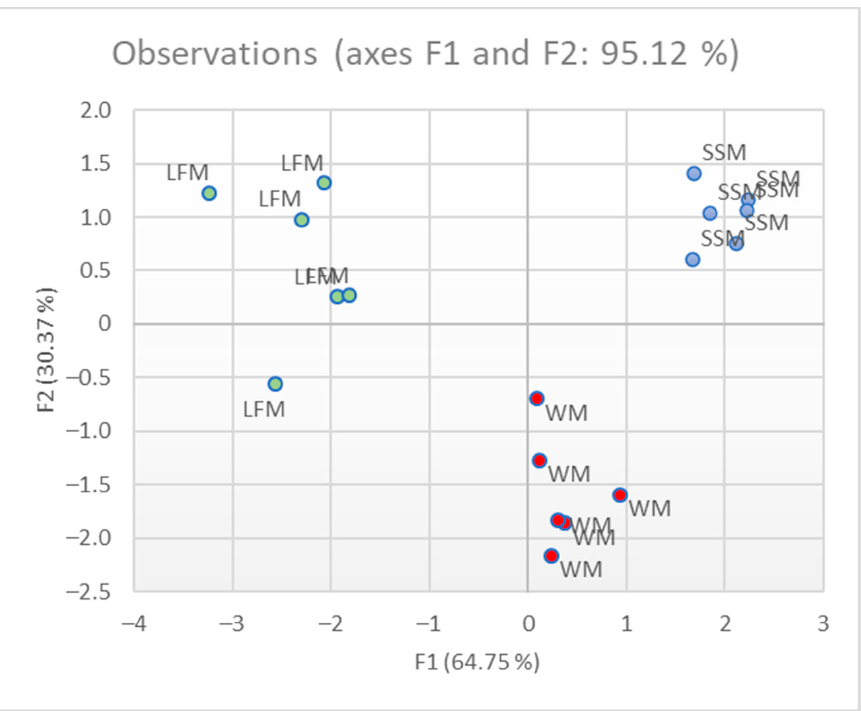
Figure 11. PCA analysis to distinguish whole milk (WM, red dots), semi-skimmed milk (SSM, blue dots) and lactose-free milk (LFM, green dots) within brand 2. The PCA has been performed starting from the five variables C , R , Q , Im ( Y ) and Re ( Y ).